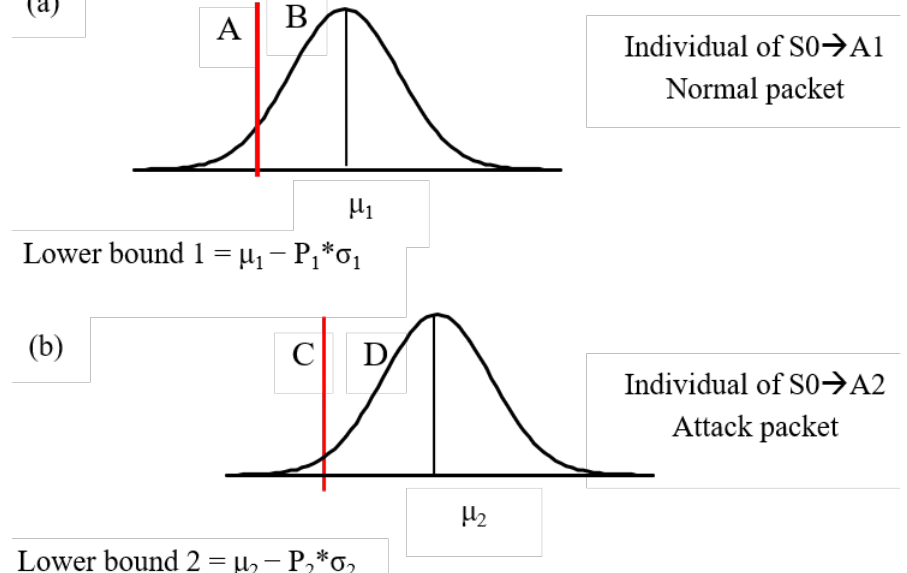
Figure 11. Attack judgment for antibody affinity. The red lines are the lower bounds of antibodies. ( a ). When the affinity between the packet and antibody is greater than that of the lower bound 1 (B) and less than that of the lower bound 2 (C), the packet can be determined to be a normal packet. ( b ) If a packet is (A) and (D) on the same time, it is an attack packet.